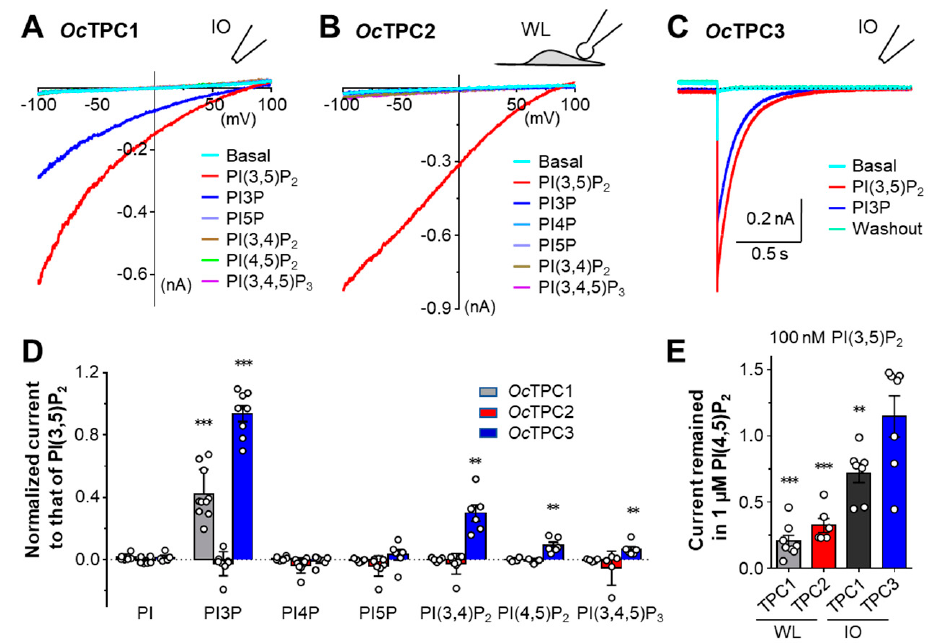
Figure 3. Rabbit TPC1, TPC2, and TPC3 display different selectivities for phosphoinositides. HEK293 cells transiently transfected with cDNA coding for Oc TPC1-EGFP, Oc TPC2-EGFP, or Oc TPC3-EGFP as indicated were used for voltage-clamp recording using either inside-out (IO, for TPC1 and TPC3) or whole-endolysosome (WL, for TPC2) configurations. ( A ) Representative I–V curves derived from voltage ramps for Oc TPC1 in an IO patch exposed to 100 nM indicated phosphoinositides in the bath. ( B ) Representative I–V curves derived from voltage ramps for Oc TPC2 in a WL patch exposed to 1 µ M indicated phosphoinositides in the bath. ( C ) Representative current traces of Oc TPC3 detected in an IO patch exposed to 1 µ M indicated phosphoinositides in the bath. The voltage was stepped from the holding potential at 0 mV to +100 mV for 4 s before returning to 0 mV. Only the last 0.3 s of the +100-mV step and the tail at 0 mV are shown for clarity. Dashed line indicates zero current. ( D ) Summary of peak currents at − 100 mV (for TPC1 and TPC2) and tail currents at 0 mV (for TPC3) elicited by the indicated phosphoinositides normalized to that by PI(3,5)P 2 . Data are means ± SEM for n = 3–11 patches. White circles represent individual data points. ** p < 0.01, *** p < 0.001, different from the theoretical mean of 0 by one-sample t -test. ( E ) Current in the presence of 100 nM PI(3,5)P 2 plus 1 µ M PI(4,5)P 2 normalized to that in 100 nM PI(3,5)P 2 for WL and IO patches obtained from cells that expressed Oc TPC1, Oc TPC2, or Oc TPC3 as indicated. For TPC1 and TPC2, currents at − 100 mV obtained from voltage ramps were analyzed; for TPC3, tail currents from 0 mV following the step to +100 mV were analyzed. Data are means ± SEM for n = 6–8 patches. ** p < 0.01, *** p < 0.001, different from the theoretical mean of 1 by one-sample t